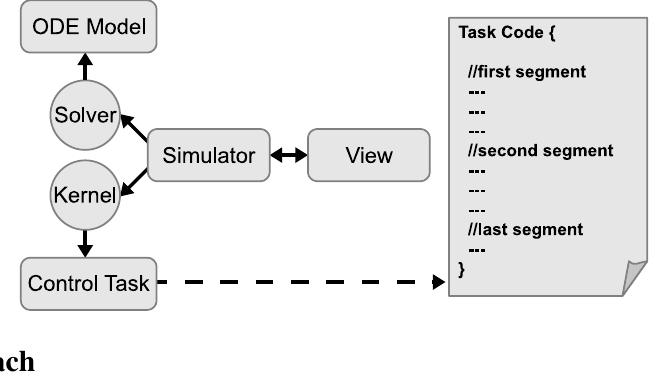
Figure 5. Diagram of an embedded control system simulation with JTT. Kernel simulation is provided by JTT, Solver and View have to be programmed or facilitated by other Java tools like